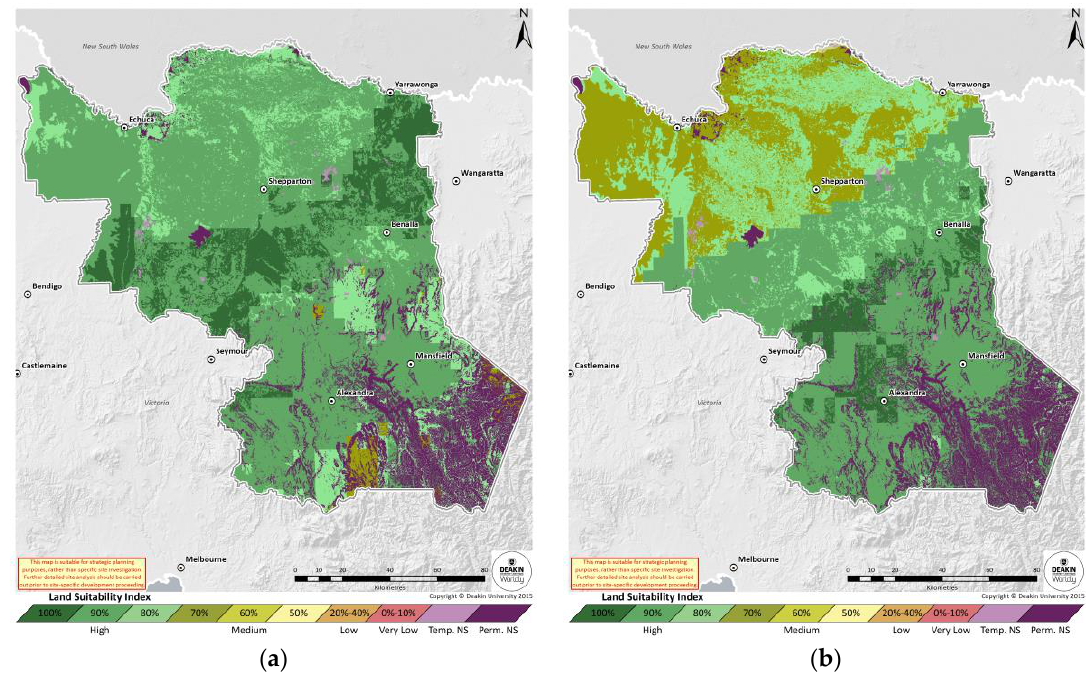
Figure 5. Standard Boolean Analytical Hierarchy Process model output for ( a ) climate normal ( b ) 2050.